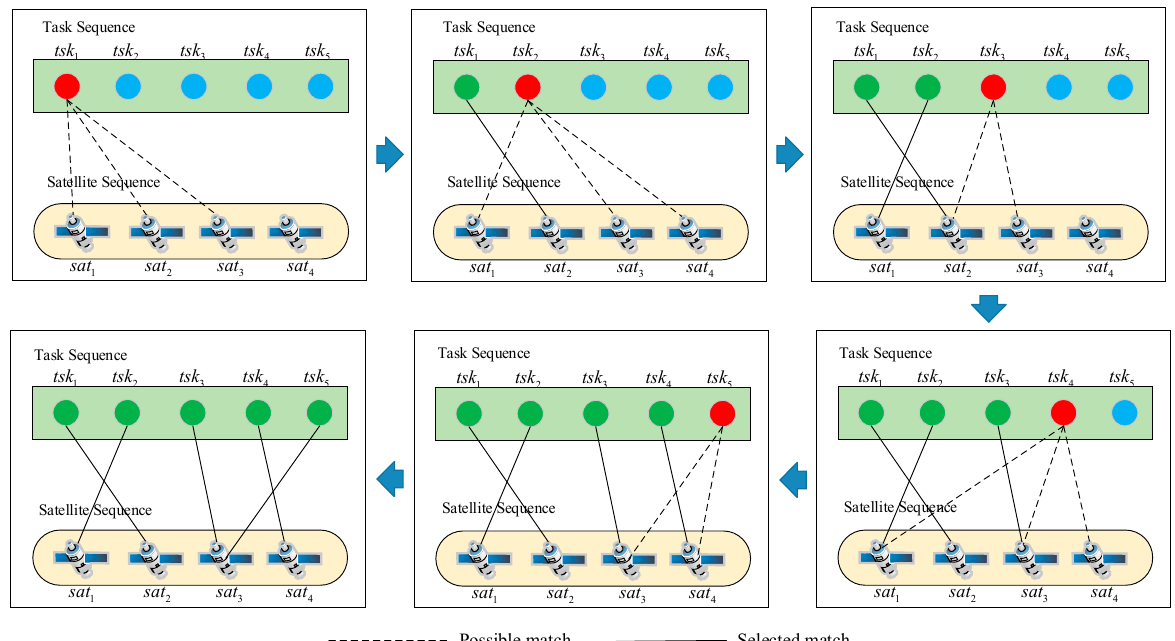
Figure 2. The sequential decision-making model for MSCTAP.